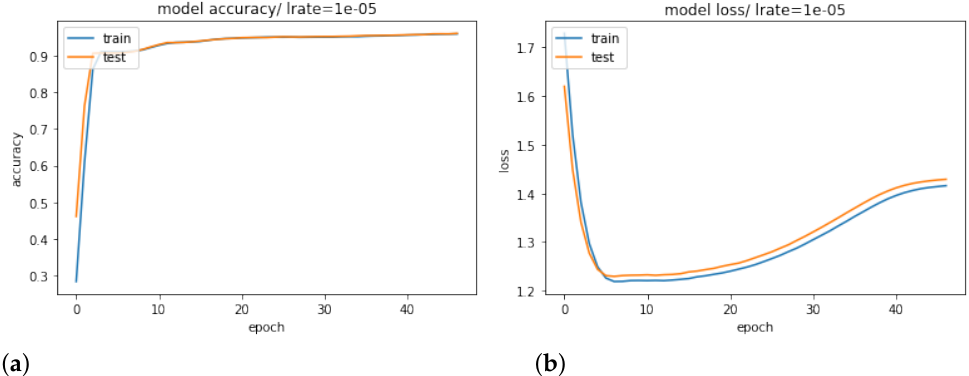
Figure 11. lr = 1 × 10 − 5 . ( a ) Train accuracy: 0.961. ( b ) Test accuracy: 0.962.